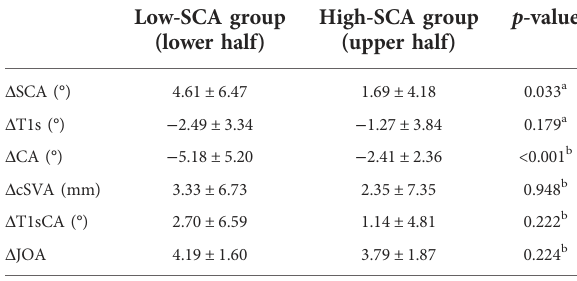
TABLE 3 Comparison of sagittal alignment and clinical outcome changes according to preoperative SCA.